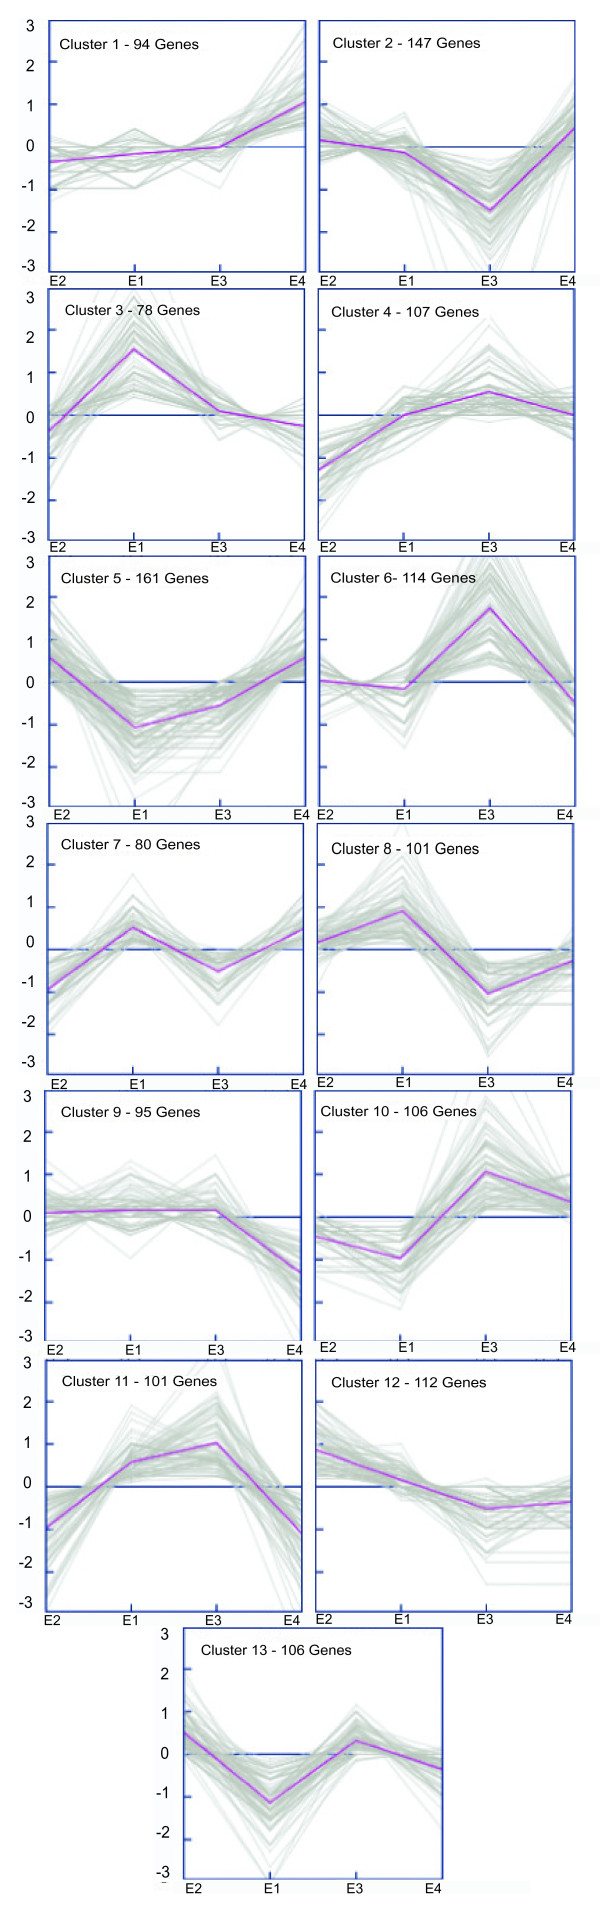
Expression profiles of clusters of genes with similar expression patterns. K-means clustering was performed with 1,402 normalized Unigenes with five or more ESTs. Relative expression levels (log2 ratios) of these clusters of genes are shown at different post-harvest conditions, the mean expression values are represented by the magenta lines. Genes were grouped into 13 clusters with distinct expression profiles. The optimal number of clusters was determined by Figure of Merit Analyses (Supplementary Figure S2). The expression levels for ripe juicy fruits that have not under-gone long-term cold storage, E2 (R+, C-); non-ripe; non-long-term cold storage fruits, E1 (R-, C-); and non-ripe and ripe fruits that have undergone long-term cold storage, E3 (R-, C+) and E4 (R+, C+), respectively, appear on the graphs. The total number of genes that make up each cluster is represented in the upper left hand corner of each cluster.